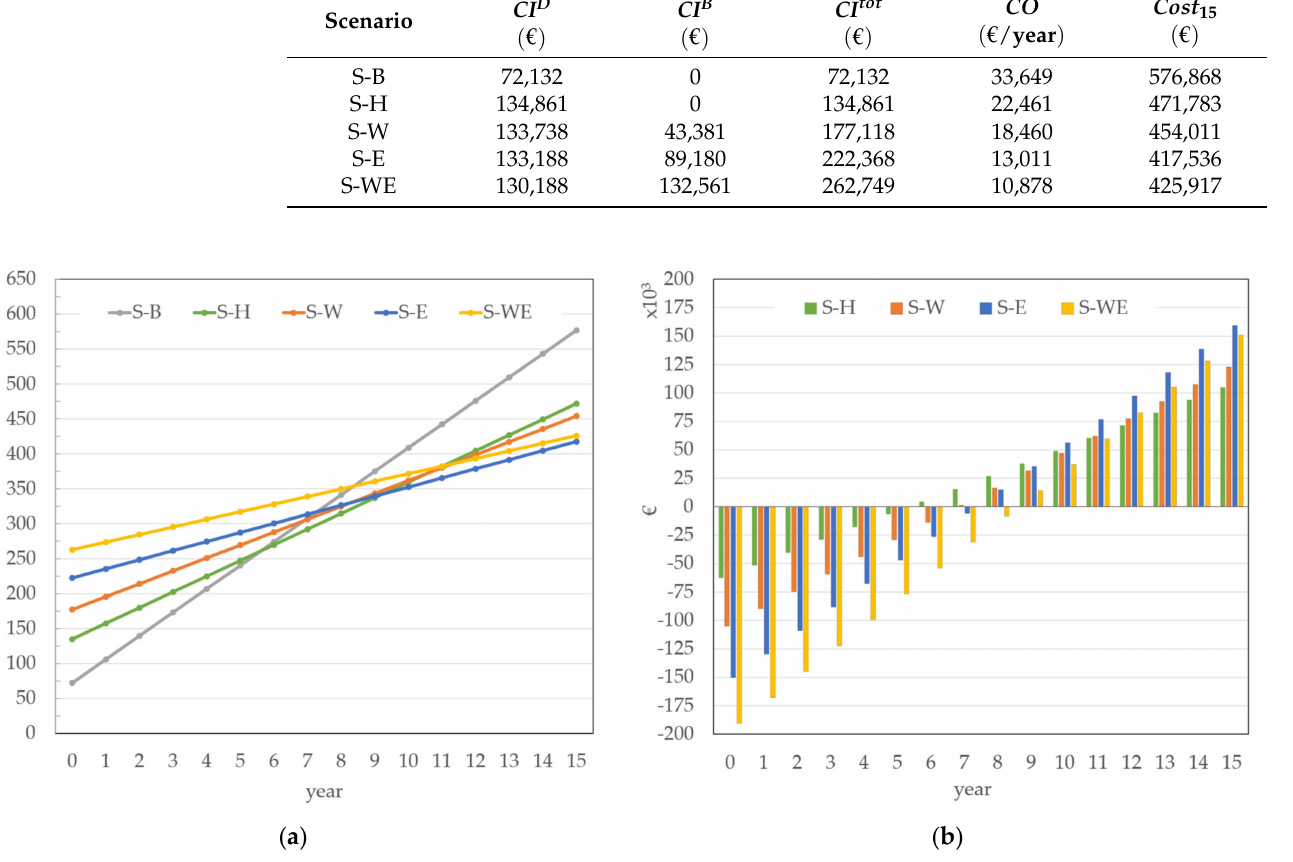
Figure 6. The 15 year projection economic analysis of: ( a ) cumulative costs; ( b ) cumulative savings compared to